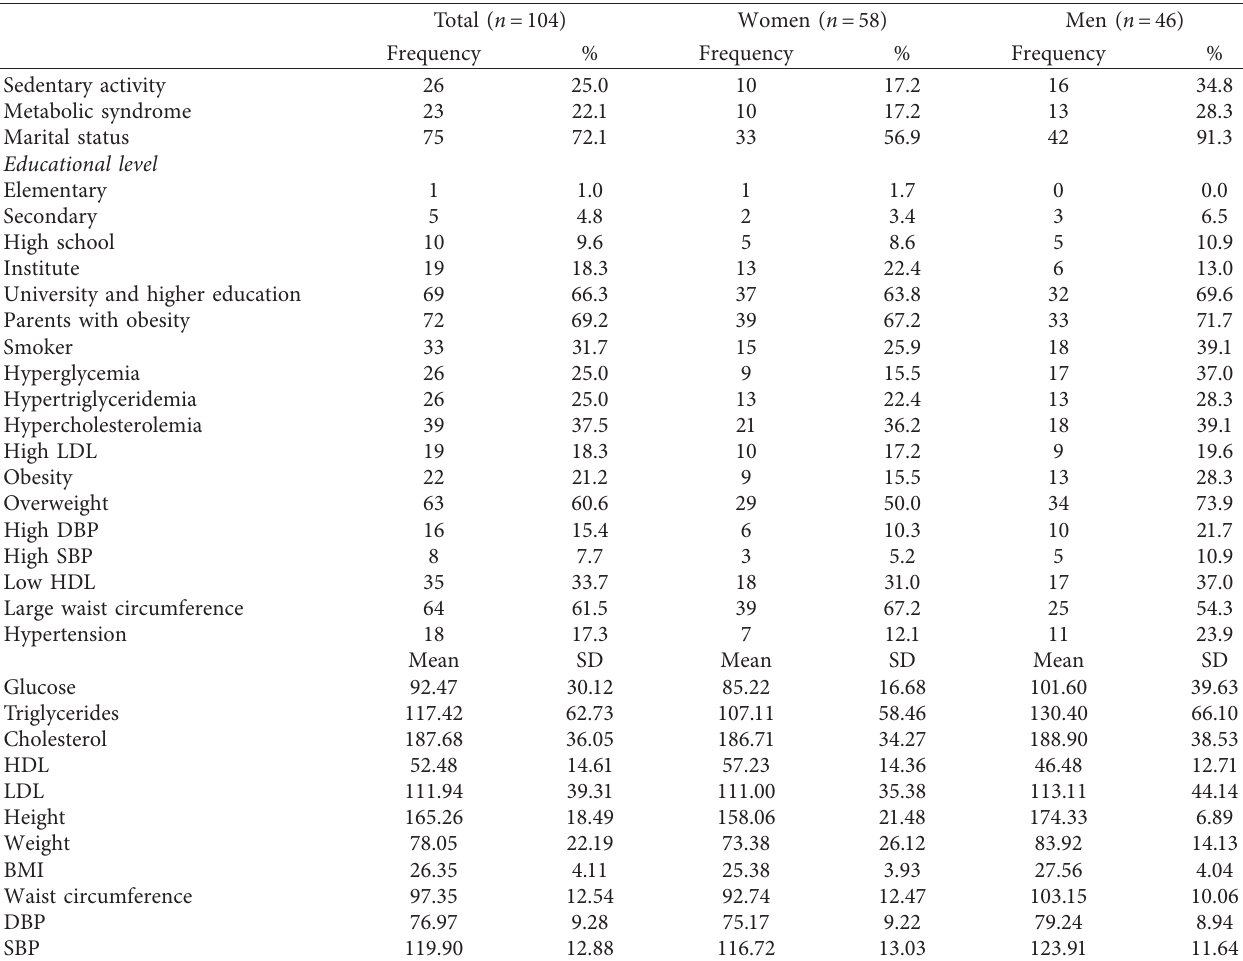
Table 1: Social, clinical, and anthropometric characteristics of the study